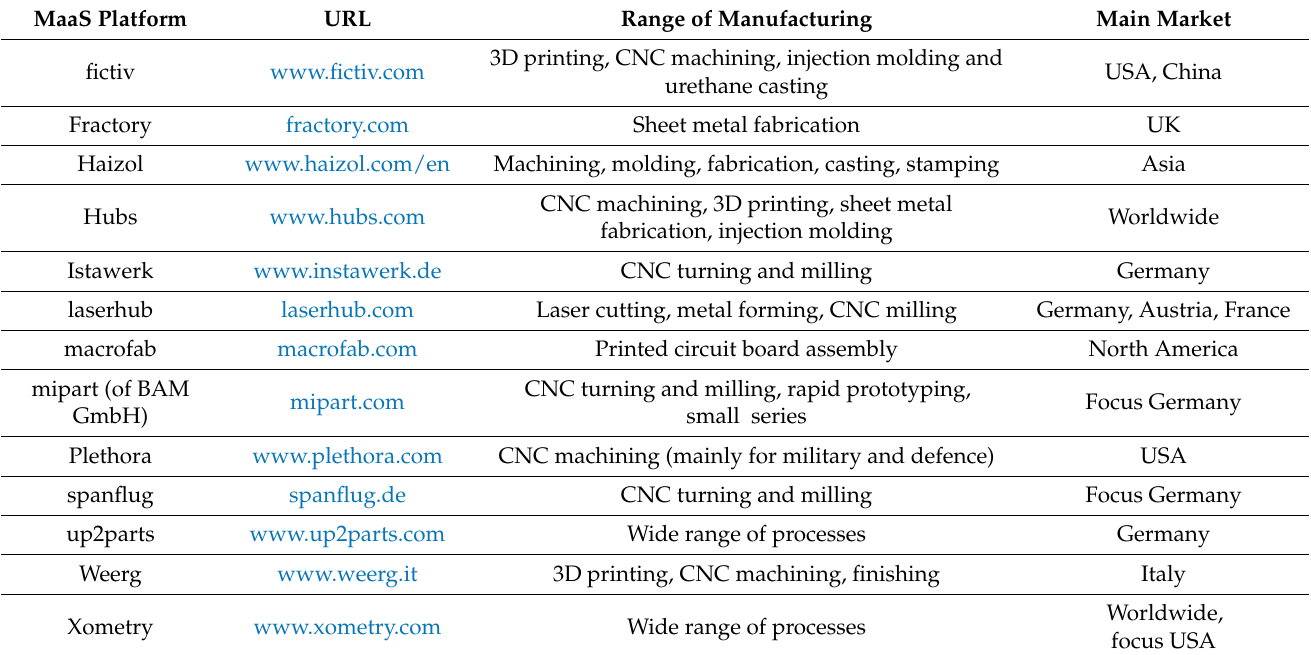
Table 4. MaaS platform examples and references (accessed on 16 July